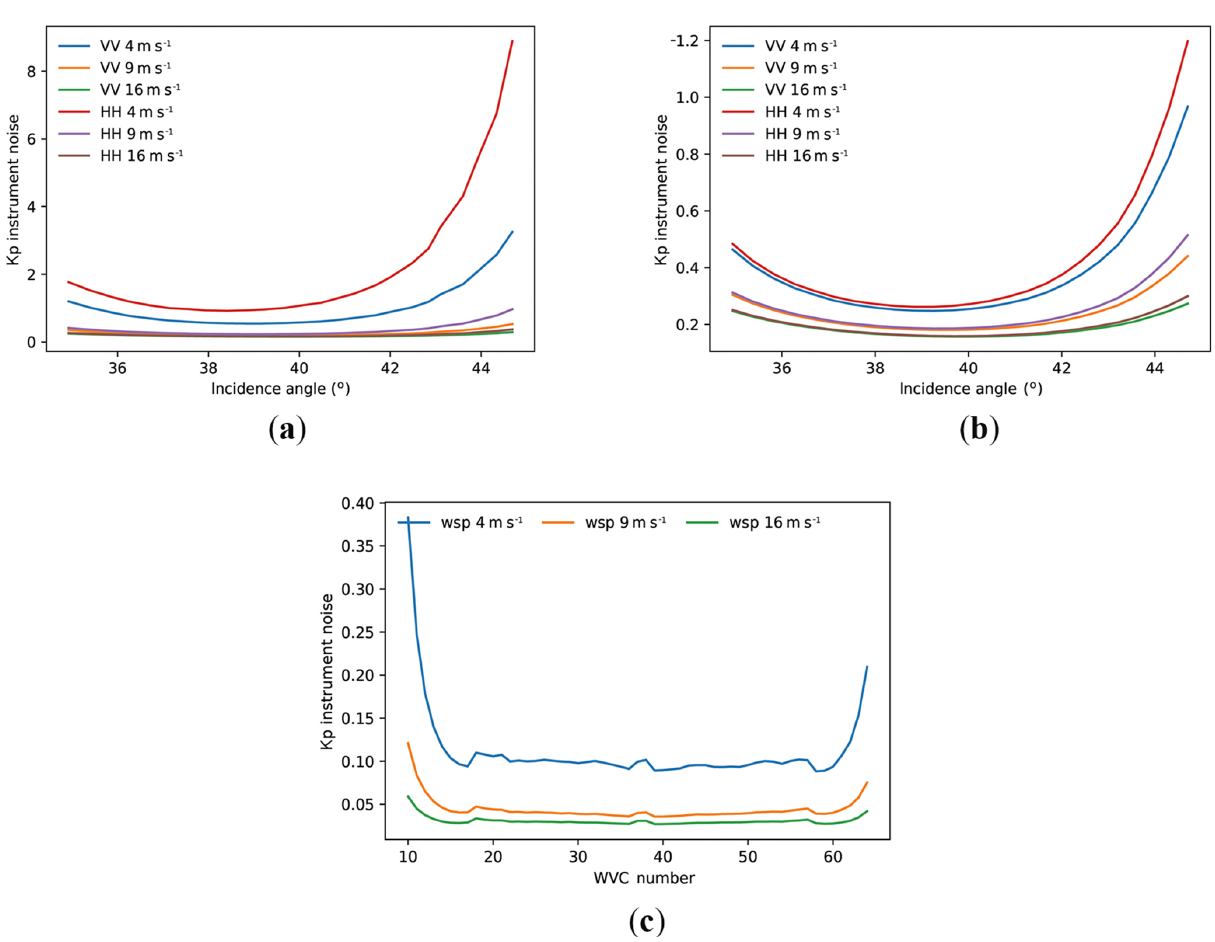
Figure 12. WindRad instrument noise in ratio (1 is 100%) at 4, 9, and 16ms − 1 on (a) slice level of the Ku band, (b) slice level of the C band (slices with SNR < 0 . 05 are excluded), and (c) WVC mean